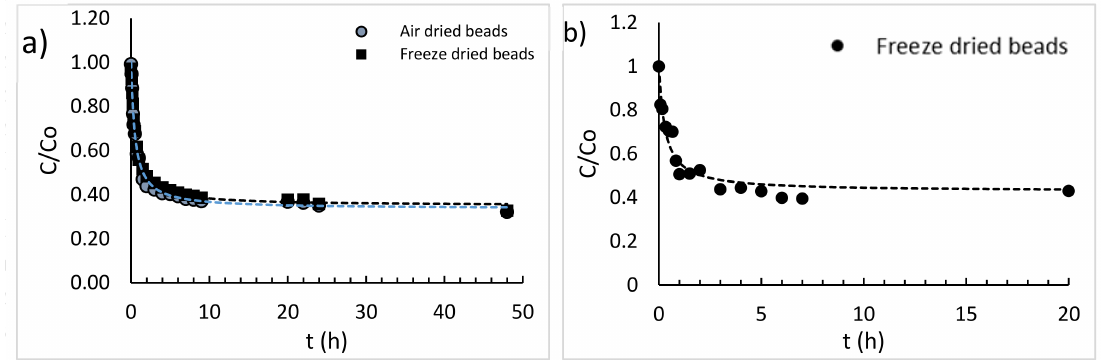
Figure 8. Kinetics profiles: ( a ) Hg(II), ( b ) Pb(II). ( T : 20 ◦ C; sorbent dosage: 1 g · L − 1 ; agitation speed: 180 rpm; contact time: 48 h; C 0 : 0.2 mmol · L − 1 ; dashed line: fitting with pseudo-second order rate